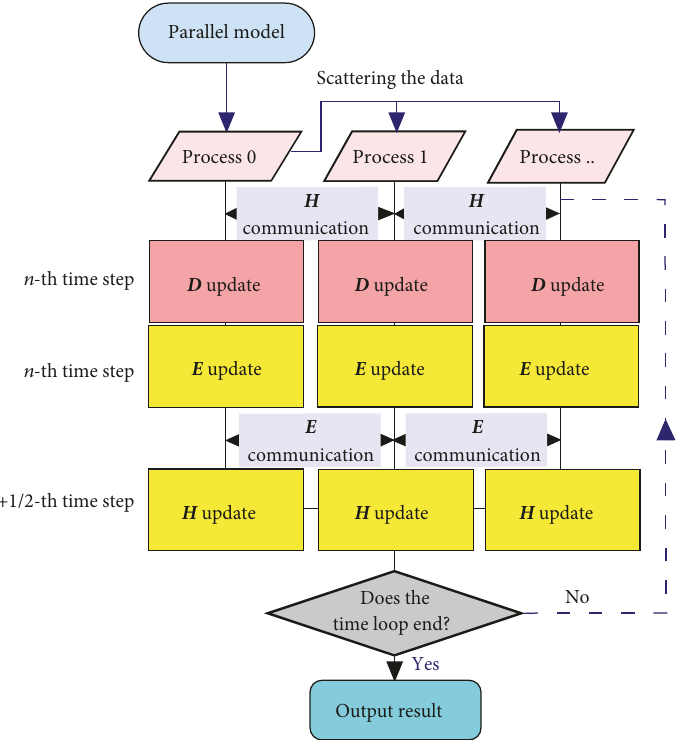
Figure 5: Calculation strategy.